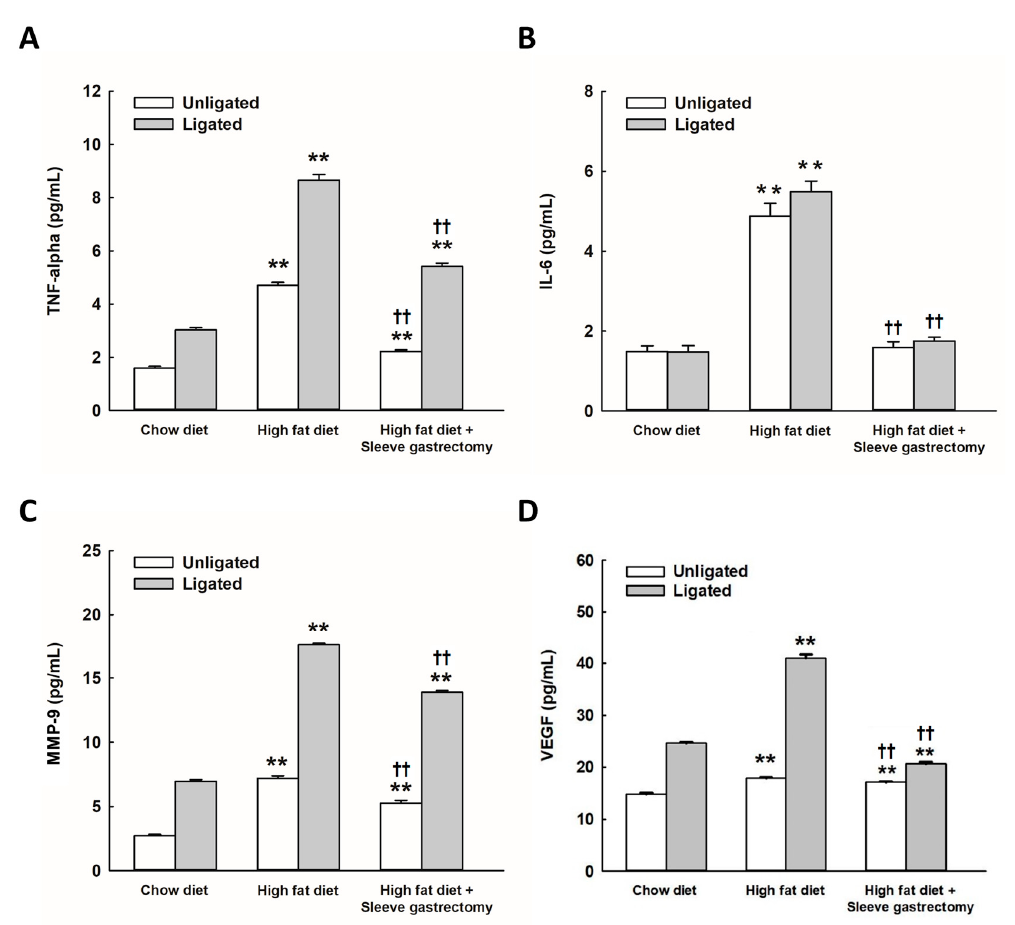
Figure 2. SG alleviated the levels of circulating HFD-induced inflammatory cytokines. The circulat- ing concentrations of TNF- α ( A ), IL-6 ( B ), MMP-9 ( C ), and VEGF ( D ) as estimated by ELISA in